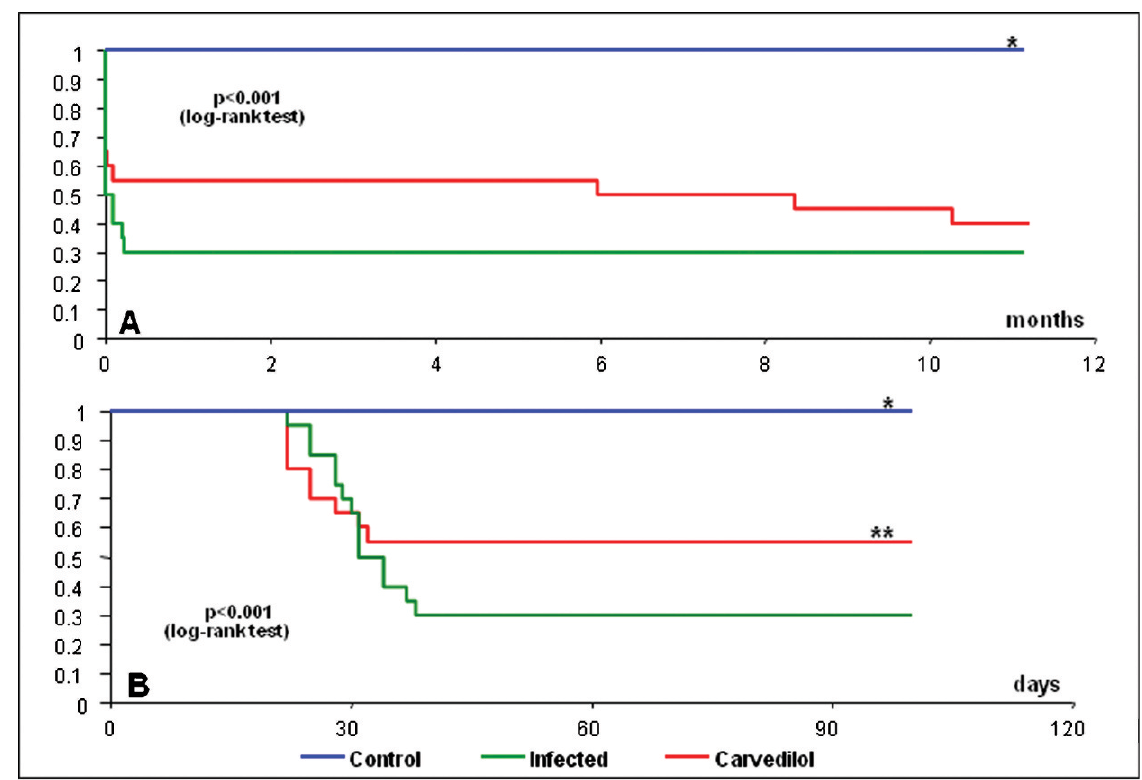
Figure 5 - A Kaplan Meier survival curve for the total study period (A), showing no significant differences between infected groups but differences between the infected groups and the control and better survival in the carvedilol group compared with the infected group in the acute phase (B). * p , 0.001 vs infected groups, ** p , 0.001 infected vs infected